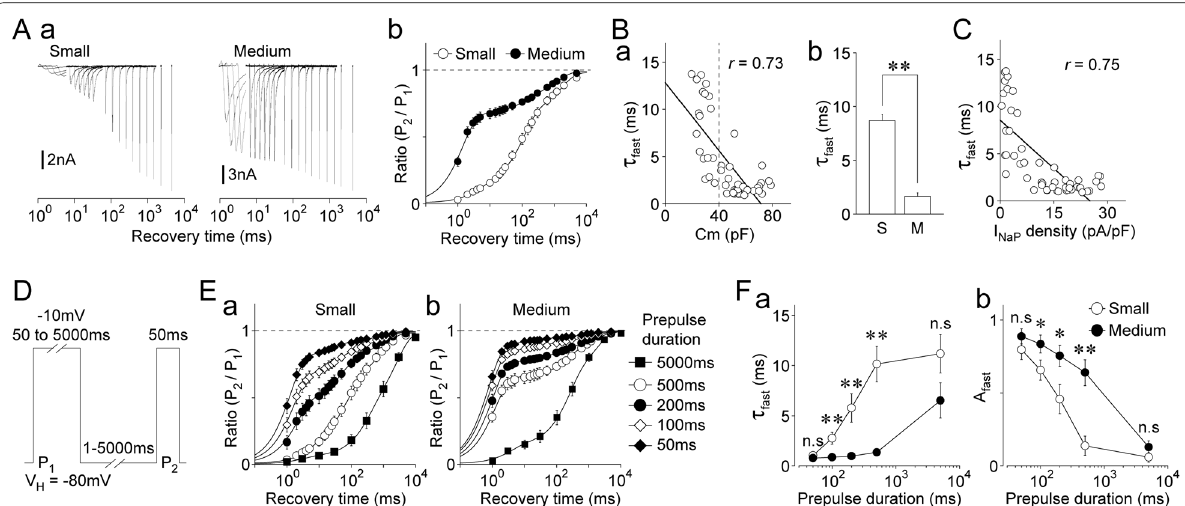
Fig. 5 Recovery kinetics of TTX‑R Na + channels in dural afferent neurons. A. a , Typical second (P 2 ) traces of TTX‑R I Na elicited by a two‑pulse protocol in small‑ (left) and medium‑sized (right) DiI‑positive neurons. TTX‑R I Na were induced by the conditioning pulse (P 1 : ‑10 mV; 500